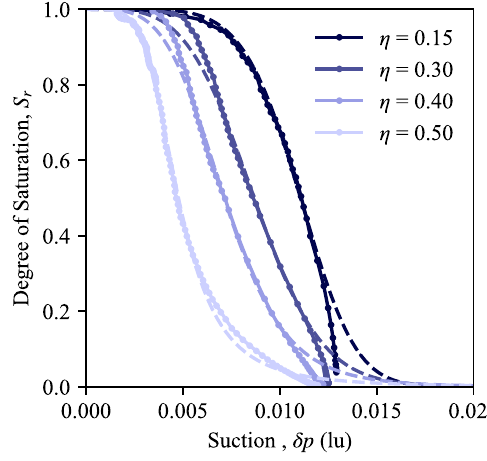
Figure 5. SWRCs from the LBM simulations for di ff erent porosities. The dashed lines represent the fitted curves based on the van Genuchten